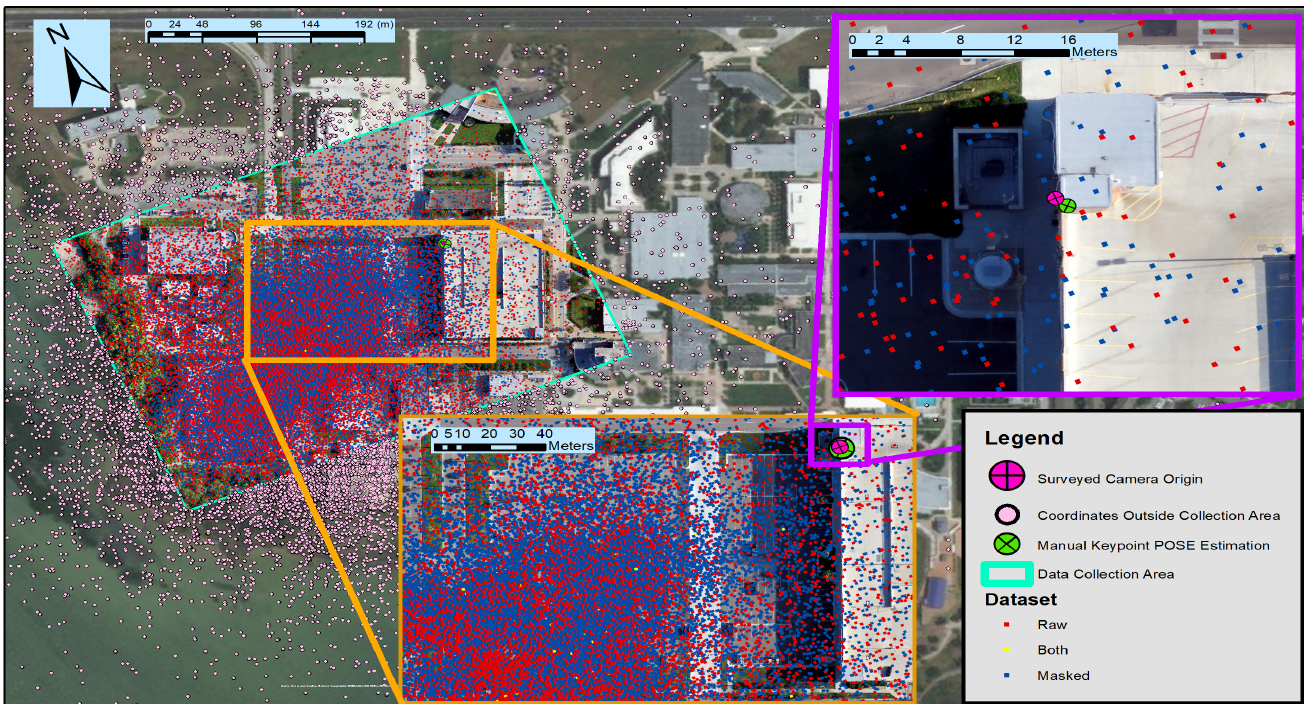
Figure 13. Categorization of pose estimation positions linked to raster pixels, shown as positions computed for the raw and masked version of the sample for all methods. The main map focuses on the data collection area, the orange inset focuses on the study area, and the purple inset focuses specifically on the area where the camera is